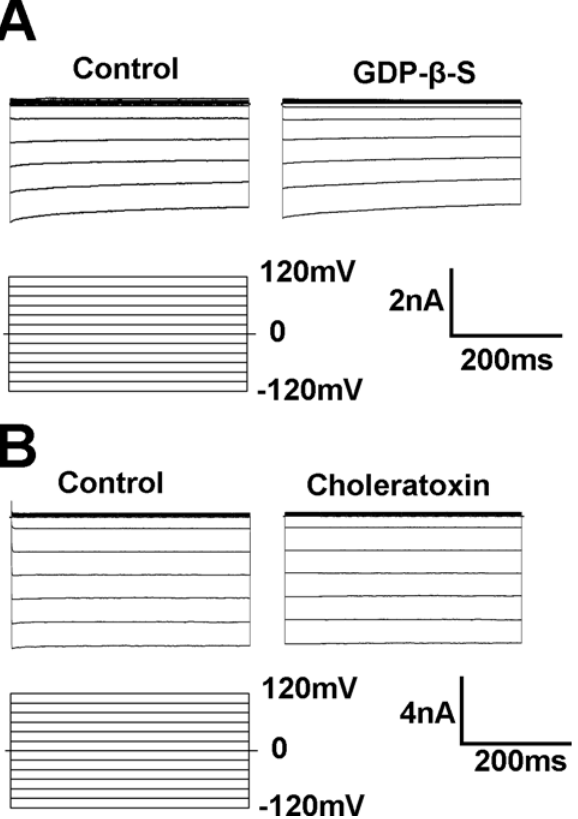
Fig 6. These currents are insensitive to GDP- β -S and choleratoxin. (A) The inhibition of G-protein signaling with the GDP- β -S did not affect the Kir currents. GDP- β -S (1 mM), a non-hydrolysable GTP analog, was applied in pipette internal solution, and whole-cell currents were studied after 15 min. (B) G-protein activator choleratoxin (0.01 M) had no significant effect on the currents in whole-cell